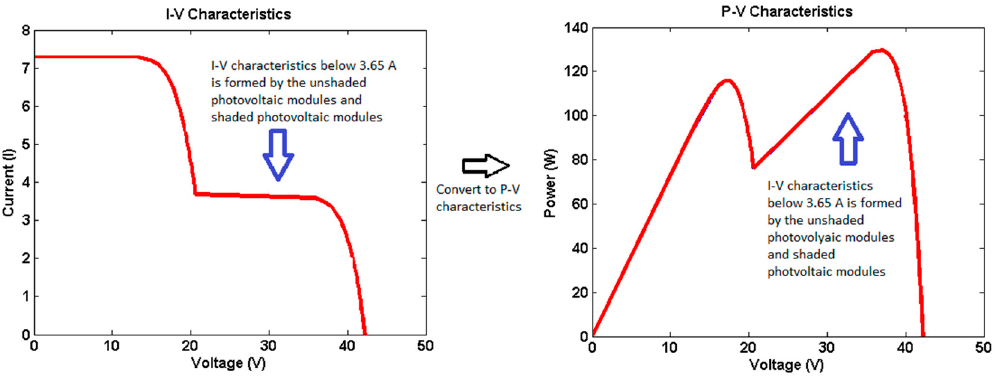
Figure 19. I-V characteristics converted to P-V characteristics.